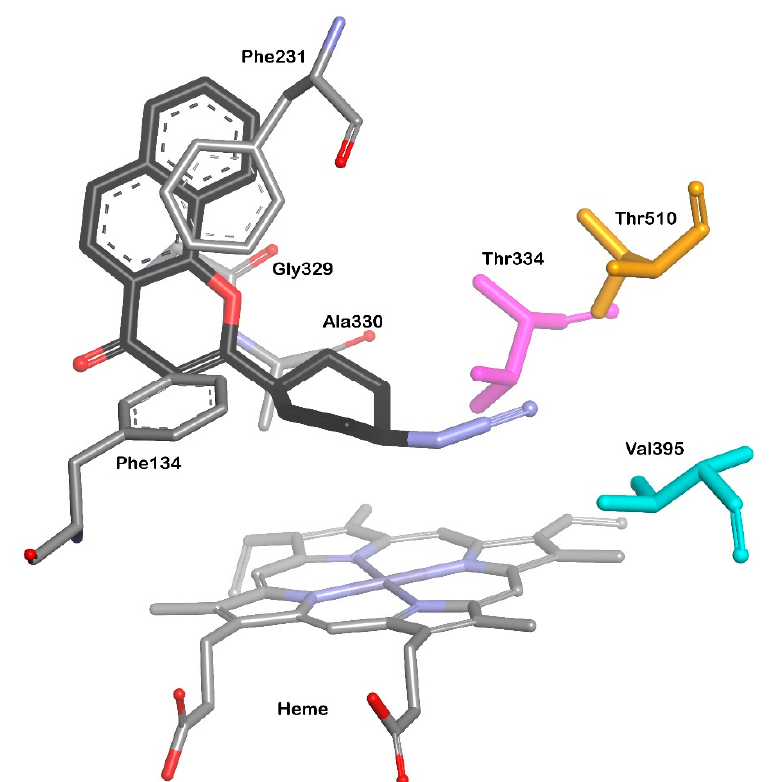
Figure 4. The orientation of inhibitor with azide group (benzo[ h ]chromone derivative) in CYP1B1 binding site. Inhibitor molecule (black carbon atoms); heme, Phe134, Phe231, Gly329, and Ala330 residues are presented as stick models in atom type. Thr334 (magenta), Val395 (cyan) and Thr510 (orange) as stick models.